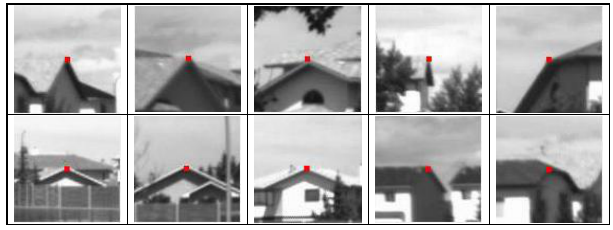
Figure 13. Matching results of type 2 dataset.